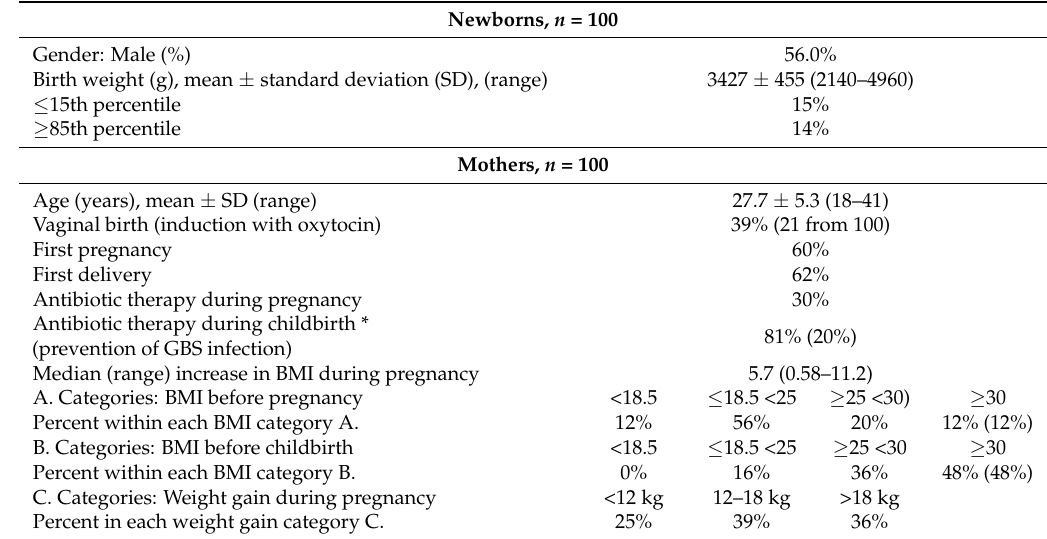
Table 1. Newborn and mother